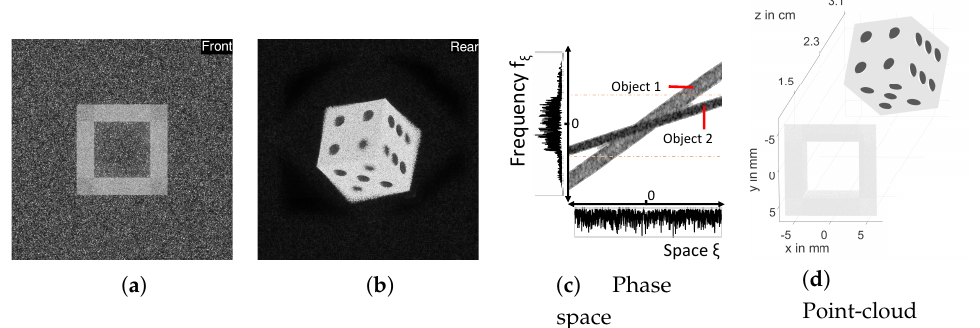
Figure 8. ( a , b ) Front and rear back-propagation of a hologram containing two objects. Only by joint consideration the entire scene is visible. ( c ) The S-method evaluated on a 1D cross-section of the hologram, shows a clear separation of (all) objects in phase space. Objects are indistinguishable in either spatial or frequency domain alone. ( d ) For reference, the point-cloud model of the scene is given. Parts of this figure are reused from